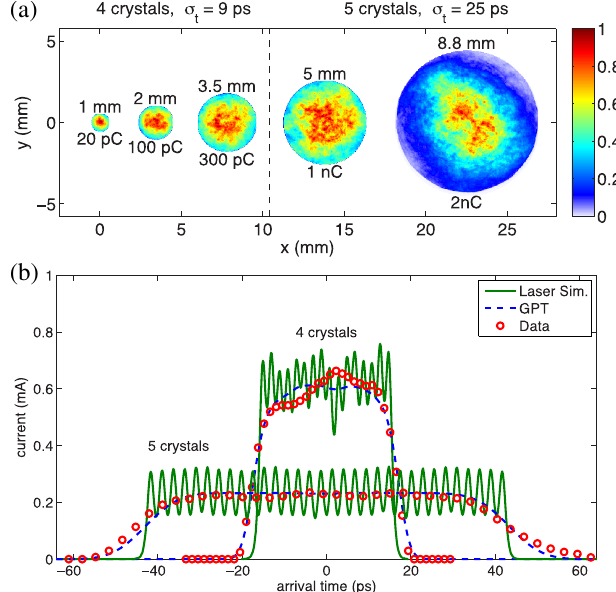
FIG. 2. Characterization of the laser distribution: (a) measured transverse laser distributions; (b) simulated temporal laser shape (green) and corresponding simulated (blue) and measured (red) temporal electron current profile at the EMS with no